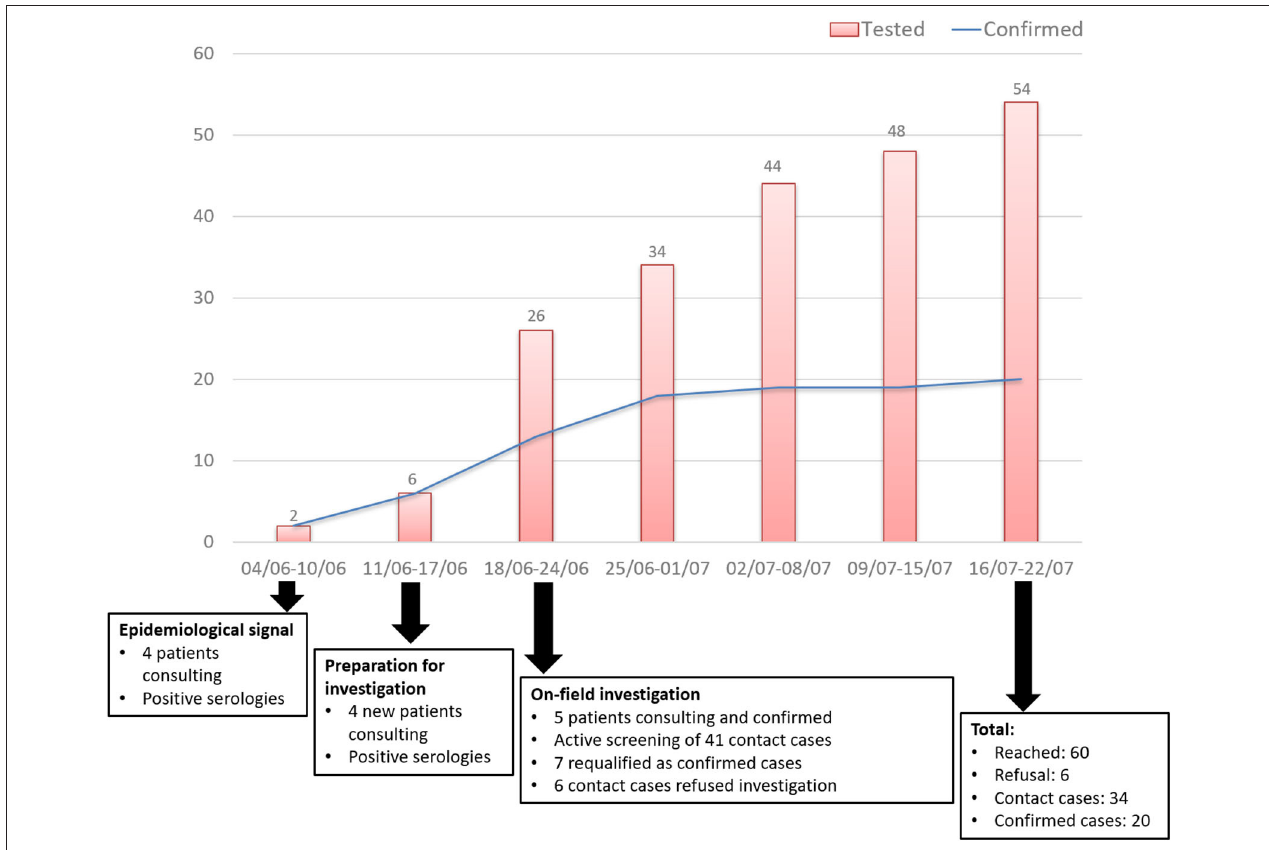
FIGURE 2 | Timeline of the investigation and epidemiological curve of tested and confirmed cases, Camopi toxoplasmosis outbreak, 2017.